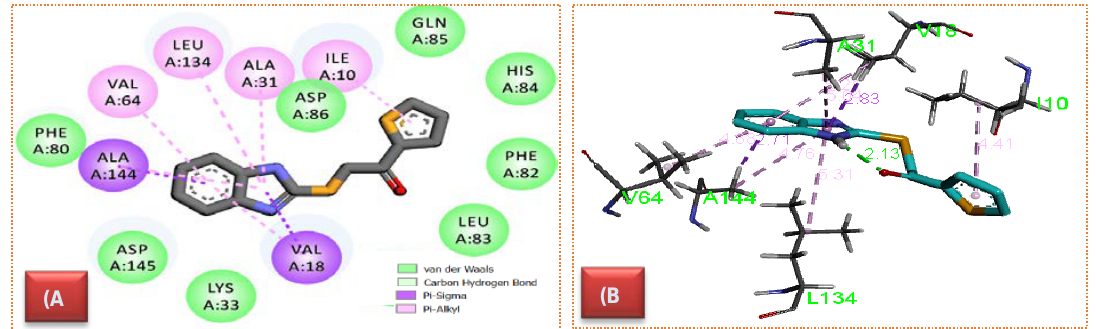
Figure 6. ( A ) 2D and ( B ) 3D diagram of benzimidazole 10e displaying its interaction within CDK2 kinase active site (distances in Å).